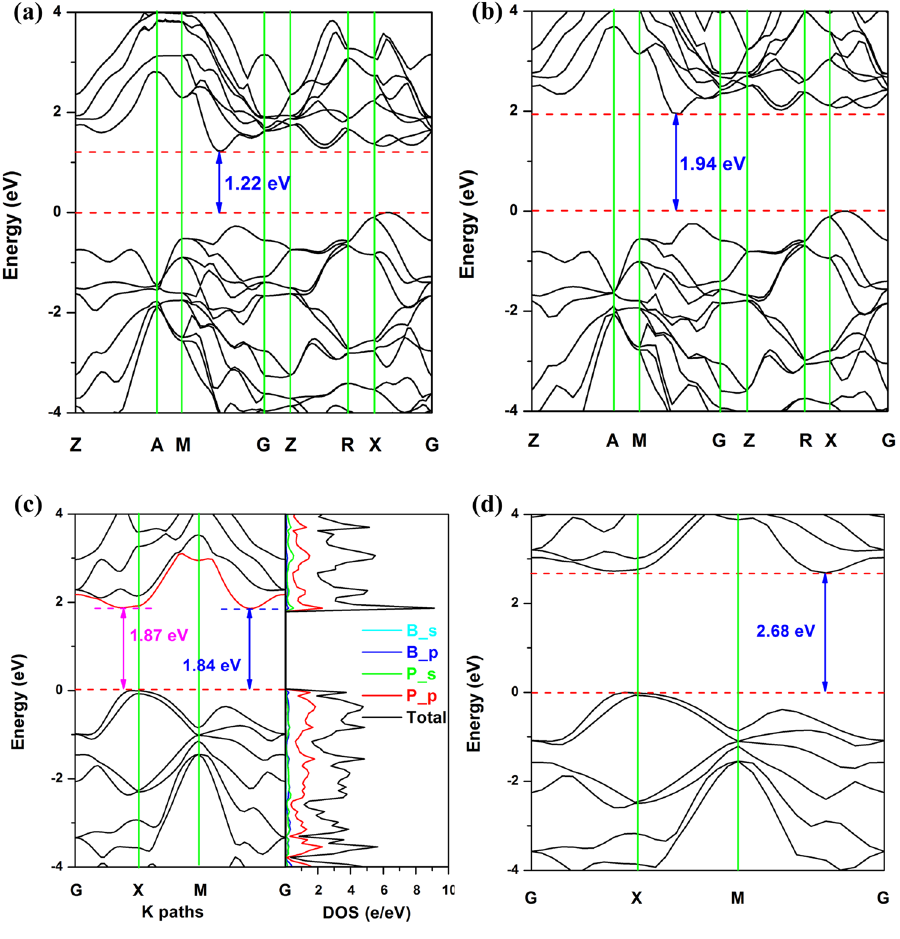
Figure 5. Band structures of penta-BP 5 bulk using ( a ) PBE and ( b ) HSE06 methods. ( c ) Band structures (left) and orbital PDOS (right) of the penta-BP 5 monolayer determined using PBE methods. ( d ) Band structures of penta-BP 5 monolayer determined using HSE06 methods. The Fermi energy was set to zero.